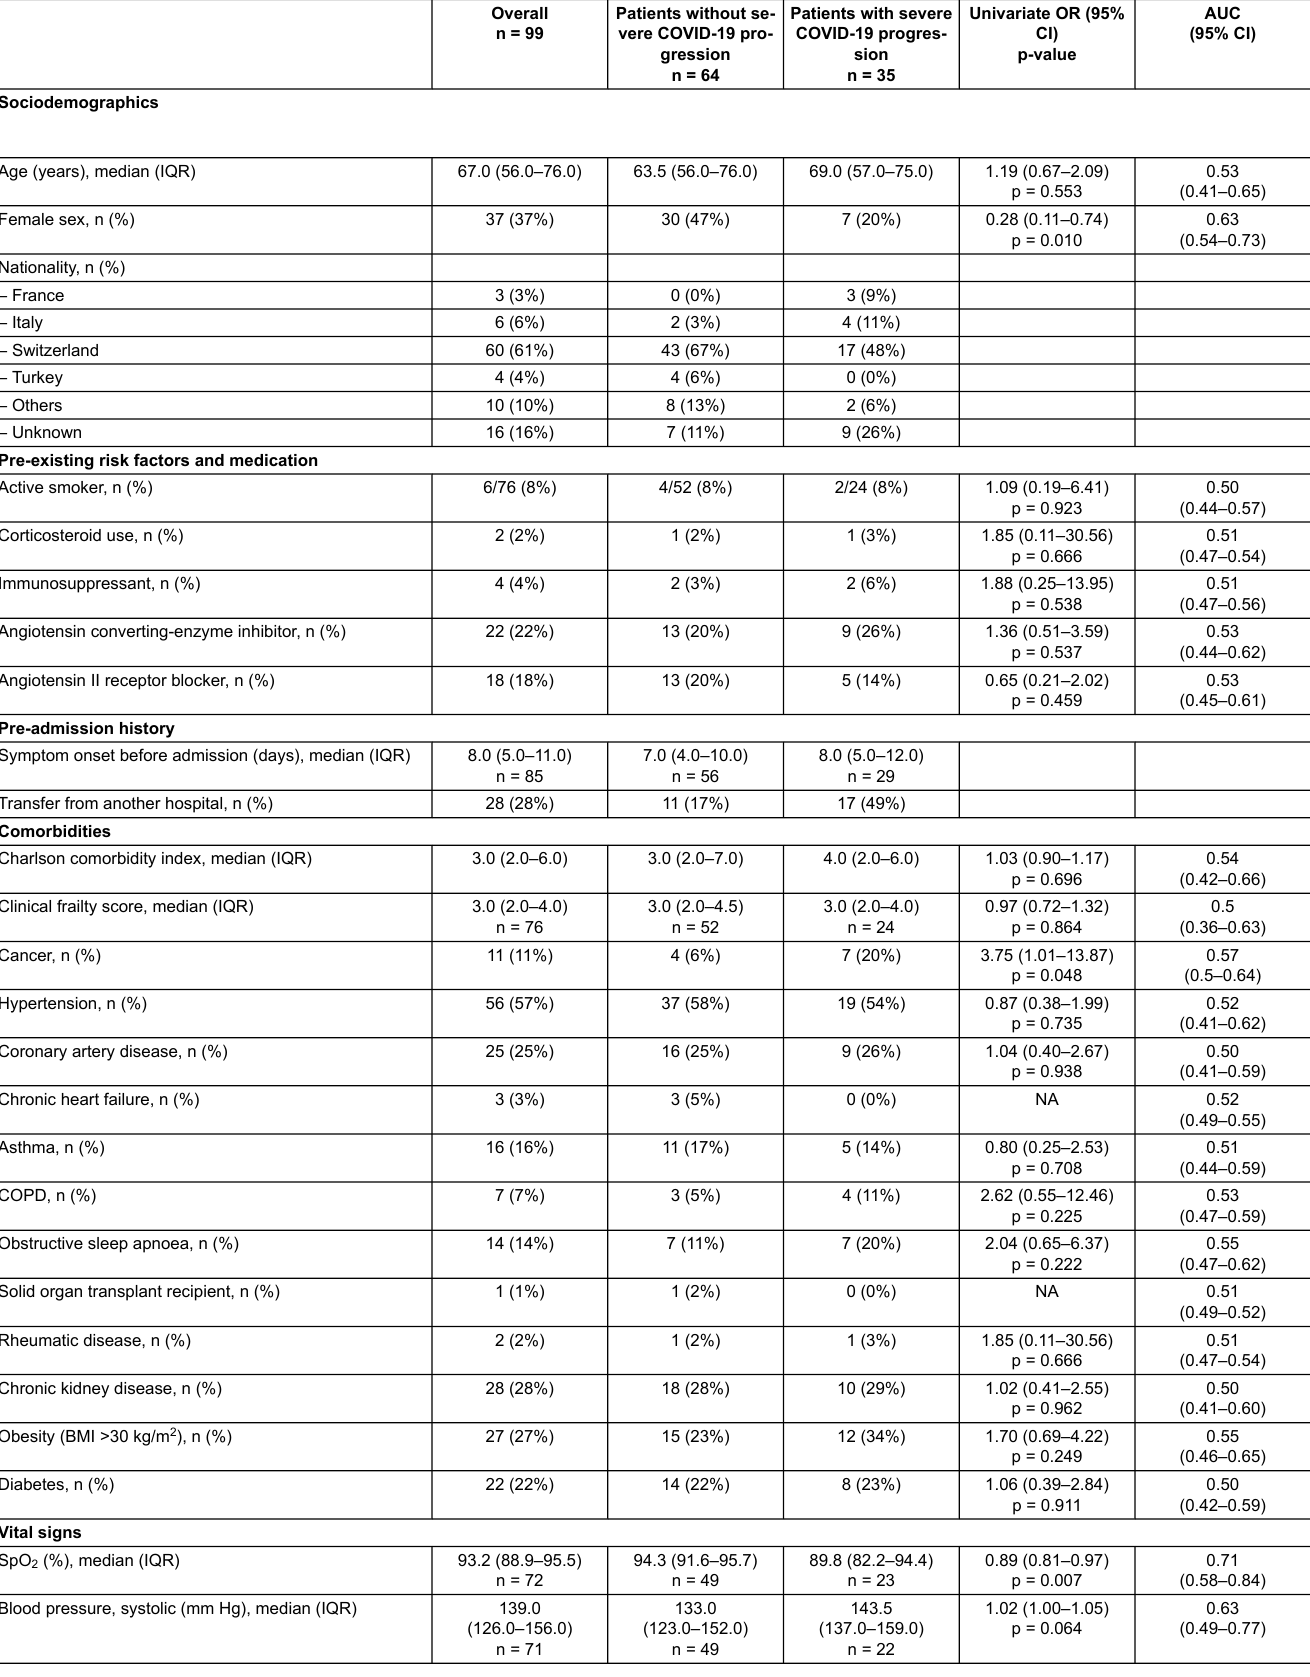
Table 1: Baseline characteristics, vital signs and laboratory results of patients hospitalised owing to COVID-19 at initial presentation in the emergency